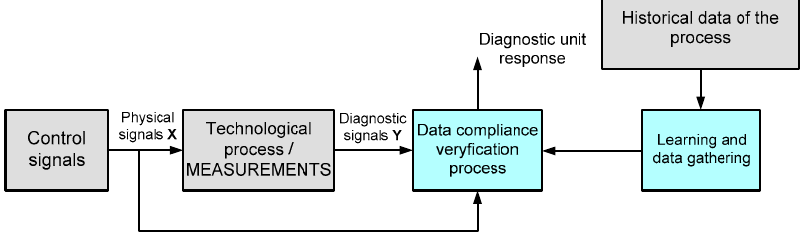
Figure 1. Data analysis based diagnostic system—general diagram.